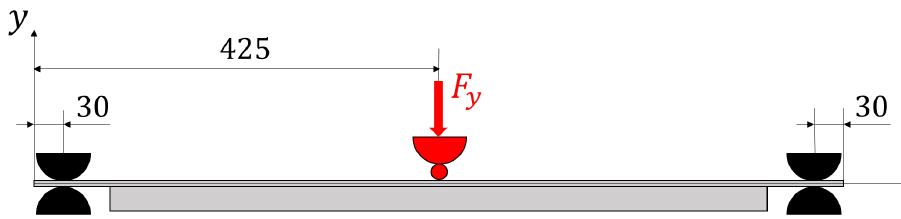
Figure 4. Scheme of the loading and boundary conditions with all dimension in mm.